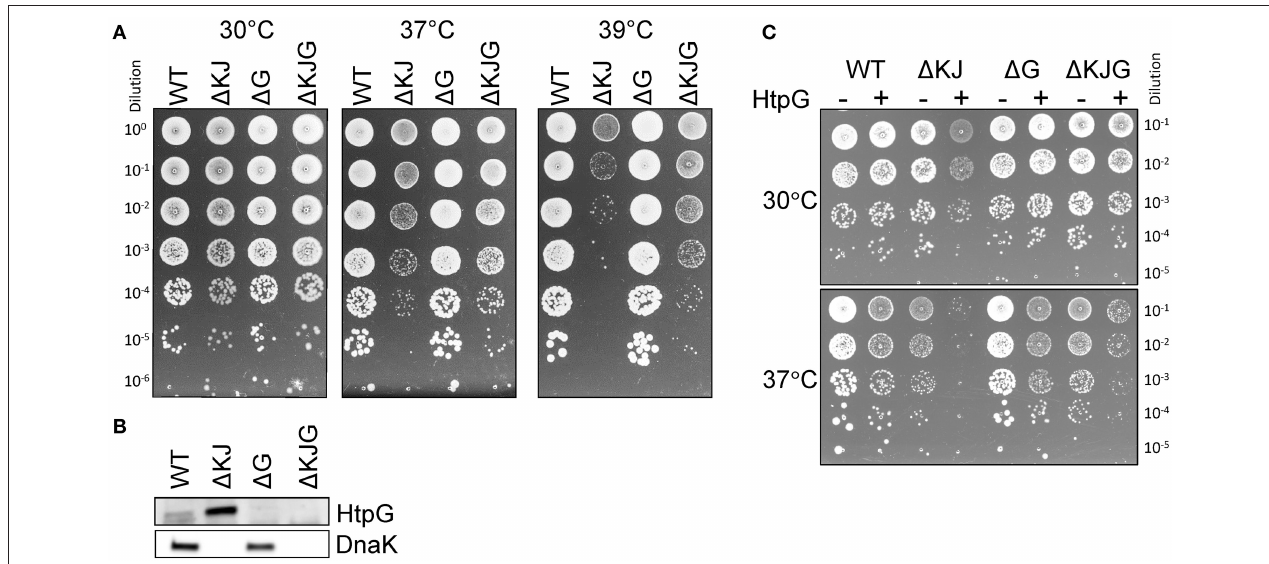
FIGURE 1 | Mutation in htpG partially suppresses the growth defect of a 1 KJ mutant. (A) Mid-log phase cultures of wild-type (WT) W3110 Escherichia coli cells, 1 KJ, 1 G, and 1 KJG E. coli strains were serially diluted 10-fold and spotted on the Luria–Bertani (LB) agar plates and grown O/N at the indicated temperatures. (B) Western blots of whole cell extracts using anti-DnaK and anti-HtpG antibodies. (C) Toxicity of HtpG overexpression in 1 KJ background. Fresh transformants of W3110 derivative strains containing either the (empty) control plasmid (pSE380-LacZ) or HtpG (pSE380-htpG) were grown at 30 ◦ C, serially diluted 10-fold and spotted on the LB ampicillin agar plates supplemented with 1 mM IPTG for induction of HtpG overexpression. Plates were incubated for 1 day at 30 ◦ C (top) or 37 ◦ C